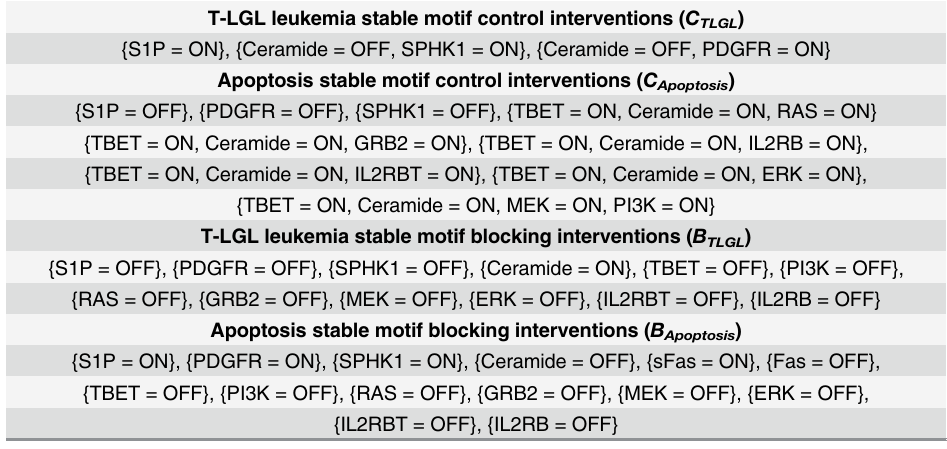
Table 1. Intervention targets for each control strategy in the T-LGL leukemia network model. T-LGL leukemia stable motif control interventions ( C TLGL ) {S1P = ON}, {Ceramide = OFF, SPHK1 = ON}, {Ceramide = OFF, PDGFR = ON} Apoptosis stable motif control interventions ( C Apoptosis ) {S1P = OFF}, {PDGFR = OFF}, {SPHK1 = OFF}, {TBET = ON, Ceramide = ON, RAS = ON} {TBET = ON, Ceramide = ON, GRB2 = ON}, {TBET = ON, Ceramide = ON, IL2RB = ON}, {TBET = ON, Ceramide = ON, IL2RBT = ON}, {TBET = ON, Ceramide = ON, ERK = ON}, {TBET = ON, Ceramide = ON, MEK = ON, PI3K = ON} T-LGL leukemia stable motif blocking interventions ( B TLGL ) {S1P = OFF}, {PDGFR = OFF}, {SPHK1 = OFF}, {Ceramide = ON}, {TBET = OFF}, {PI3K = OFF}, {RAS = OFF}, {GRB2 = OFF}, {MEK = OFF}, {ERK = OFF}, {IL2RBT = OFF}, {IL2RB = OFF} Apoptosis stable motif blocking interventions ( B Apoptosis ) {S1P = ON}, {PDGFR = ON}, {SPHK1 = ON}, {Ceramide = OFF}, {sFas = ON}, {Fas = OFF}, {TBET = OFF}, {PI3K = OFF}, {RAS = OFF}, {GRB2 = OFF}, {MEK = OFF}, {ERK = OFF}, {IL2RBT = OFF}, {IL2RB = OFF}